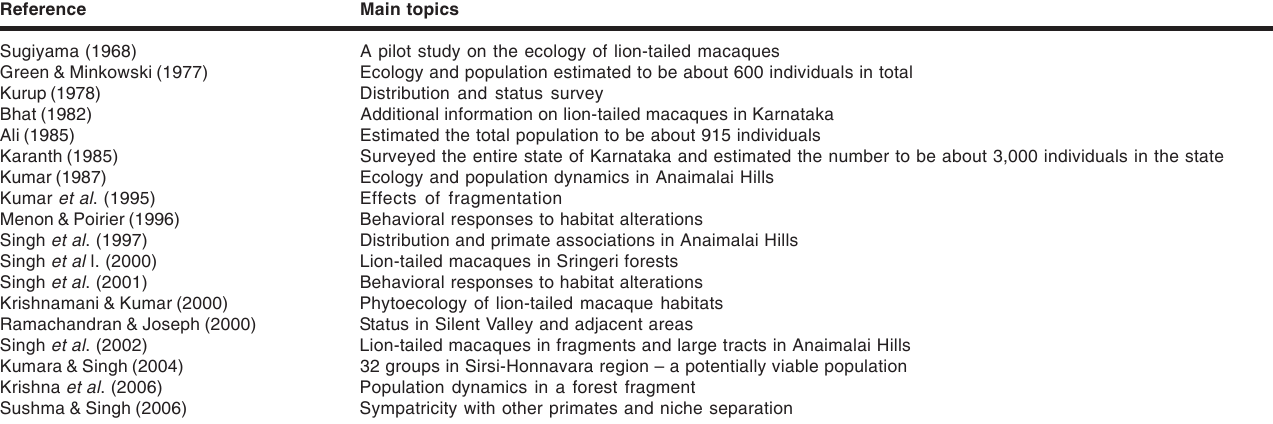
Table 1. Landmark field studies on Lion-tailed